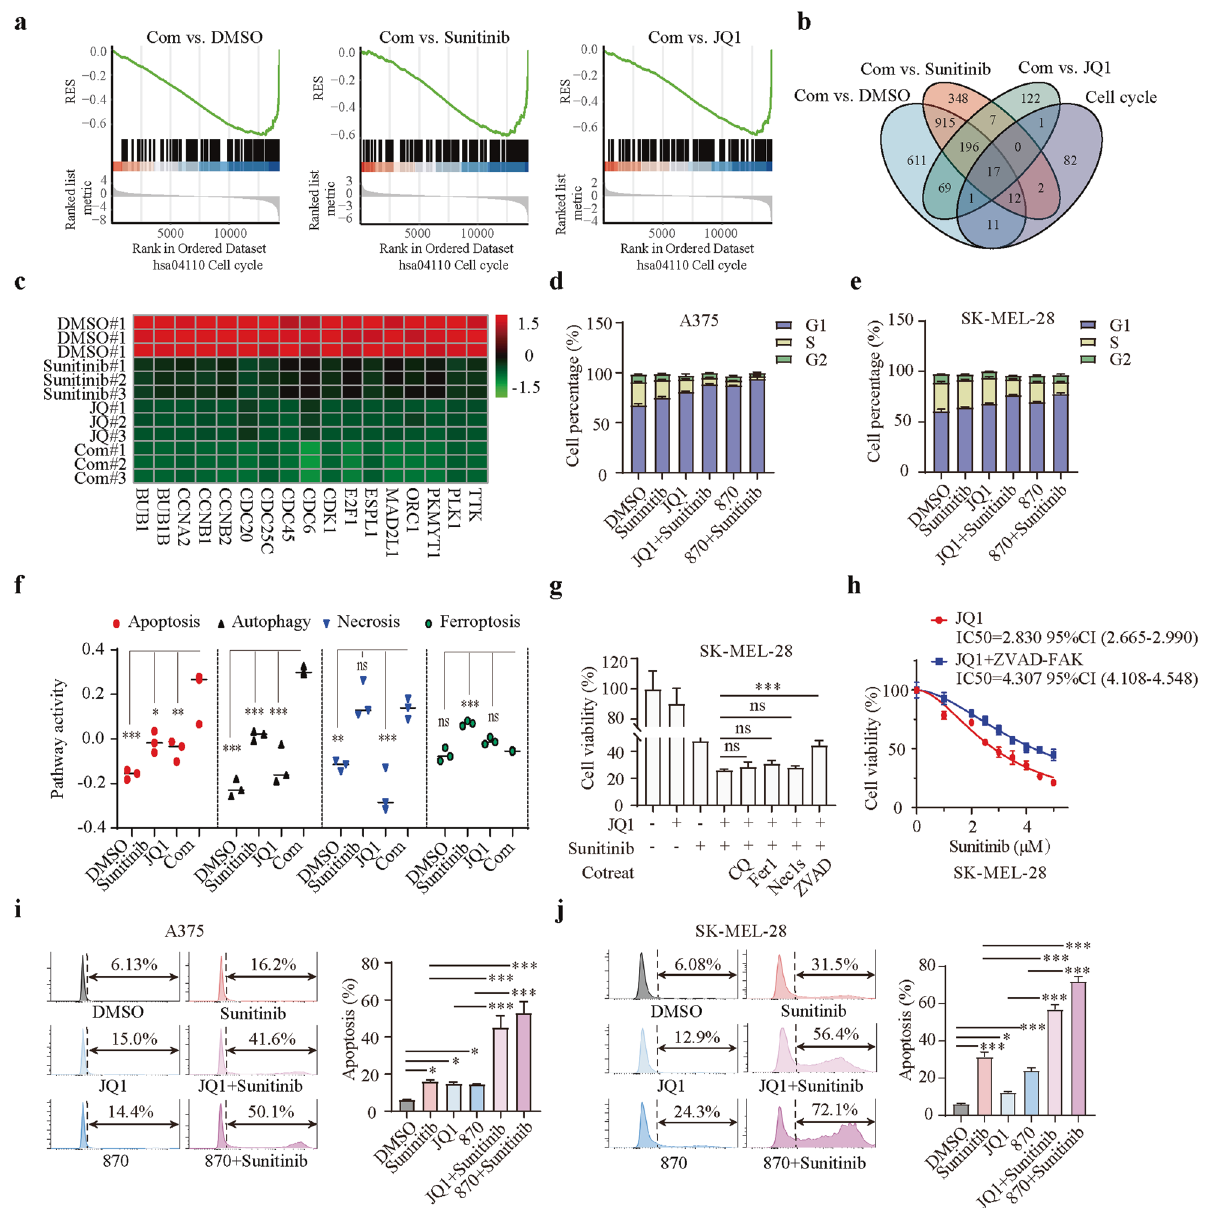
Fig. 2 Apoptosis and cell cycle arrest mediate the synergy induced by the combination treatment. a Gene set enrichment analysis (GSEA) showing that cell cycle progression was signi fi cantly inhibited in the combination group compared with the DMSO, sunitinib, and JQ1 groups. b Venn diagram of the overlapping genes in the indicated groups. c Heatmap of the 17 genes identi fi ed by the Venn diagram that were associated with the cell cycle and inhibited by the combination treatment. d , e Cell cycle distribution of A375 ( d ) and SK-MEL-28 ( e ) cells after treatment with sunitinib (1 μ M) or JQ1 (1 μ M)/NHWD-870 (10 nM) either alone or in combination for 36 h. f Gene set variation analysis (GSVA) of apoptosis-, autophagy-, necrosis-, and ferroptosis-related pathways in the indicated groups. g SK-MEL-28 cells were treated with JQ1 (1 μ M), sunitinib (1 μ M), or a combination of both drugs with or without cell death inhibitors (CQ, 10 μ M; Fer-1, 2 μ M; necrostatin-1s, 10 μ M; ZVAD-FMK, 5 μ M) for 24h, and cell viability was assessed. h Dose response of sunitinib-induced death of SK-MEL-28 cells treated with JQ1 in the absence or presence of ZVAD- FAK. i , j Apoptosis of A375 ( i ) and SK-MEL-28 ( j ) cells after treatment with sunitinib (1 μ M) or JQ1 (1 μ M)/NHWD-870 (10 nM) either alone or in combination for 36h. P values were calculated using one-way ANOVA in ( f , g , i and j ). * P < 0.05; ** P < 0.01; *** P < 0.001; ns nonsigni fi MEL-28 cells (Fig. 1f, g). In addition, to investigate the antiproliferative effect of cotreatment with BET inhibitors and sunitinib, a colony formation assay was performed, and the results showed that compared with sunitinib or BET inhibitors alone, combination treatment with sunitinib and BET inhibitors signi fi cantly suppressed melanoma cell proliferation (Fig. 1h, i). These fi ndings suggested that BET inhibitors synergize with sunitinib in melanoma.